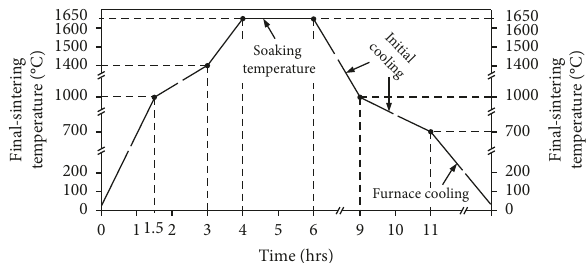
Figure 8: Temperature schedule for final sintering